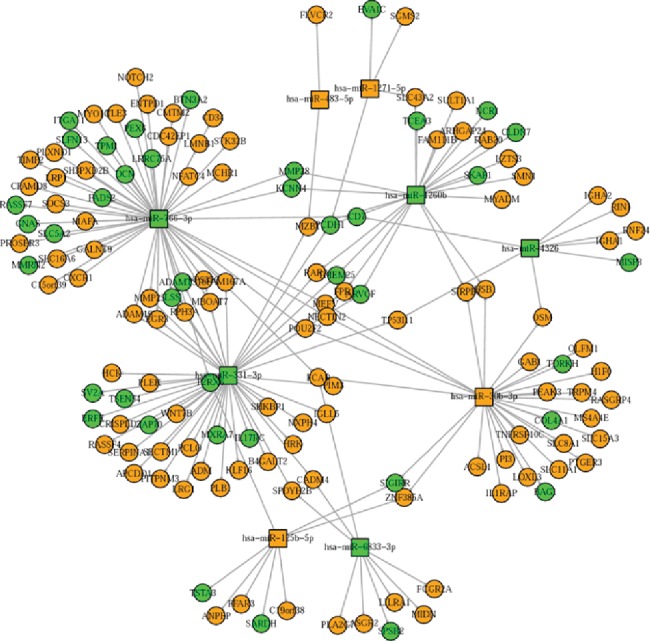
The regulatory miRNA target gene network. The regulatory miRNA gene network was analyzed using Cytoscape software. Squares and circles represent miRNA and target genes, respectively. Orange nodes represent genes that are upregulated in severe RSV-associated pneumonia, and blue nodes represent downregulated genes.